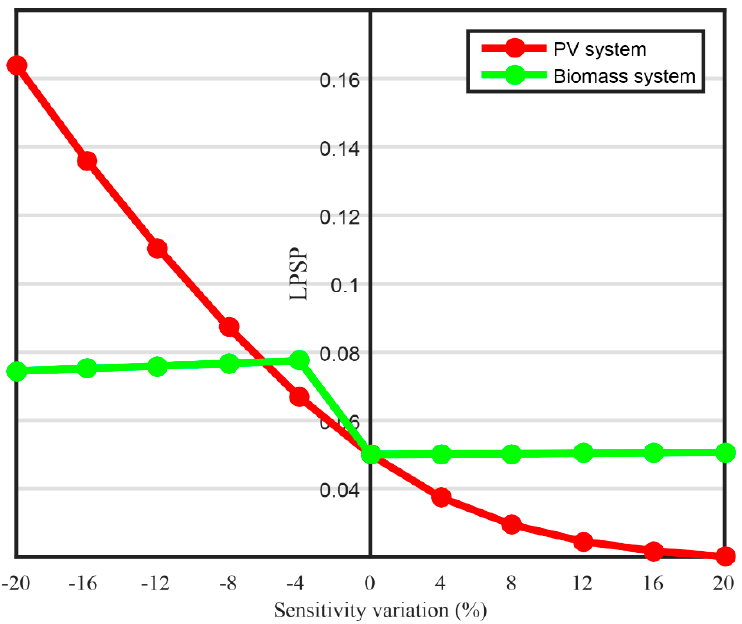
Figure 13. Sensitivity analysis application for Loss of Power Supply Probability (LPSP).